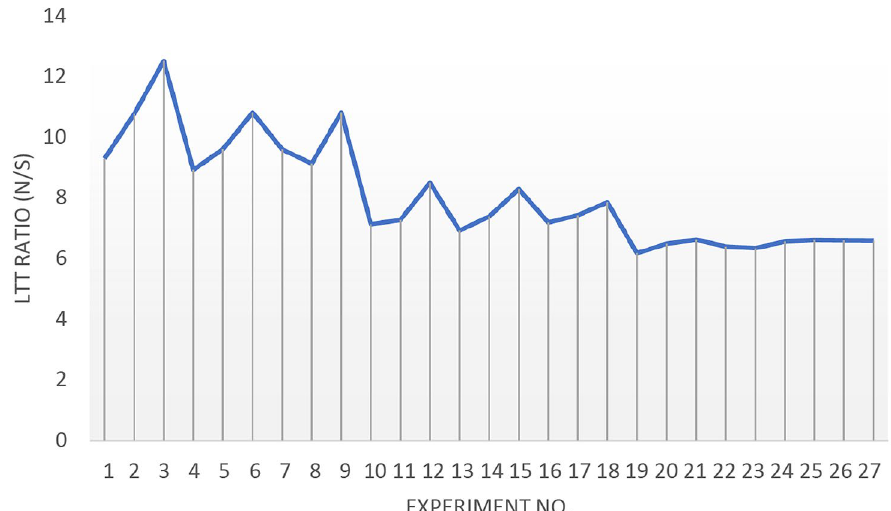
Fig. 11 LTT ratio for SS inter-